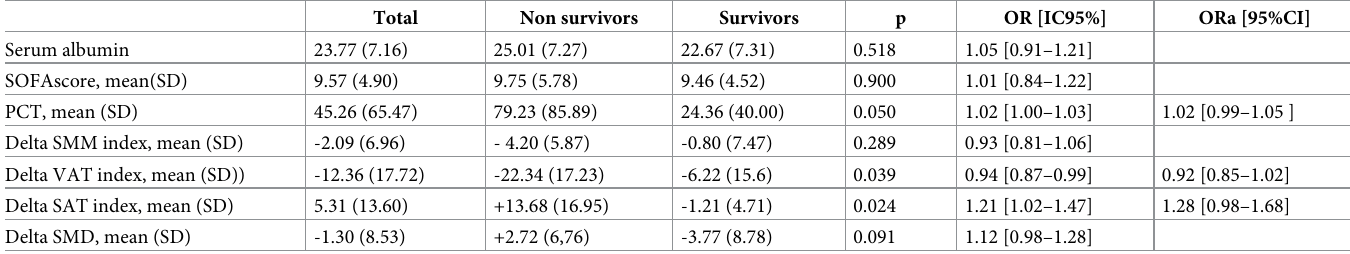
Table 5. Risk factors associated with